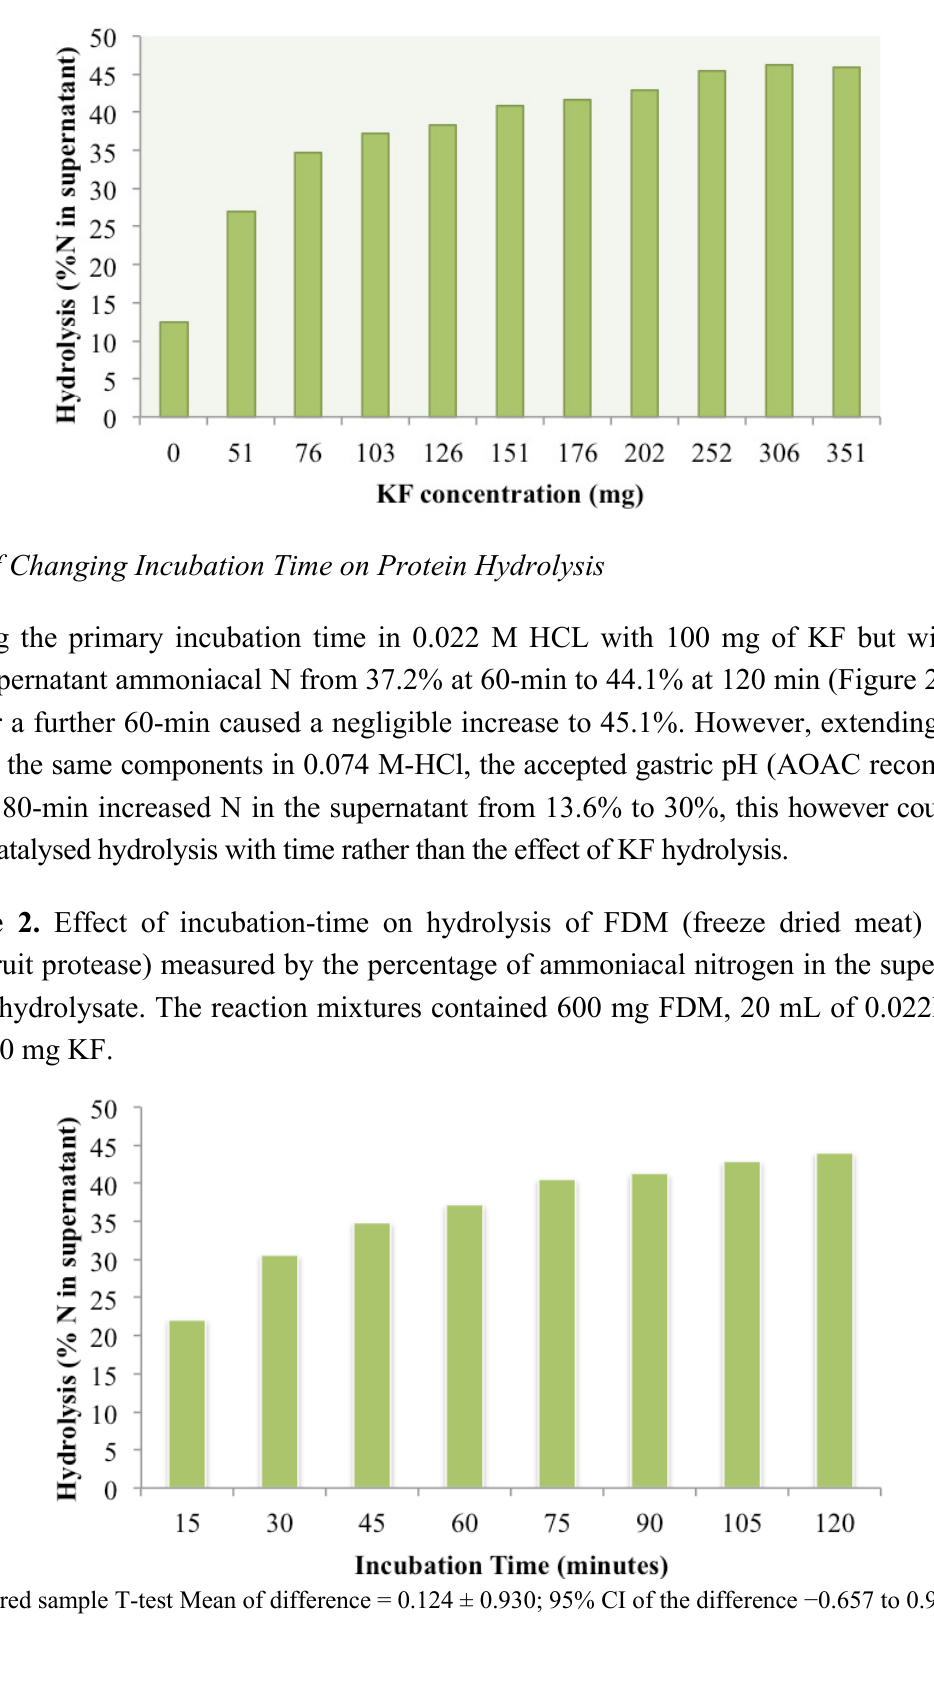
Figure 1. Effect of KF (kiwifruit protease) concentration (mg/digest) on protein hydrolysis of 600 mg FDM (freeze dried meat) measured by percentage of Kjeldahl nitrogen (N) in the supernatant after 60 min incubation in 20 mL 0.022 M HCl at 37 °C.